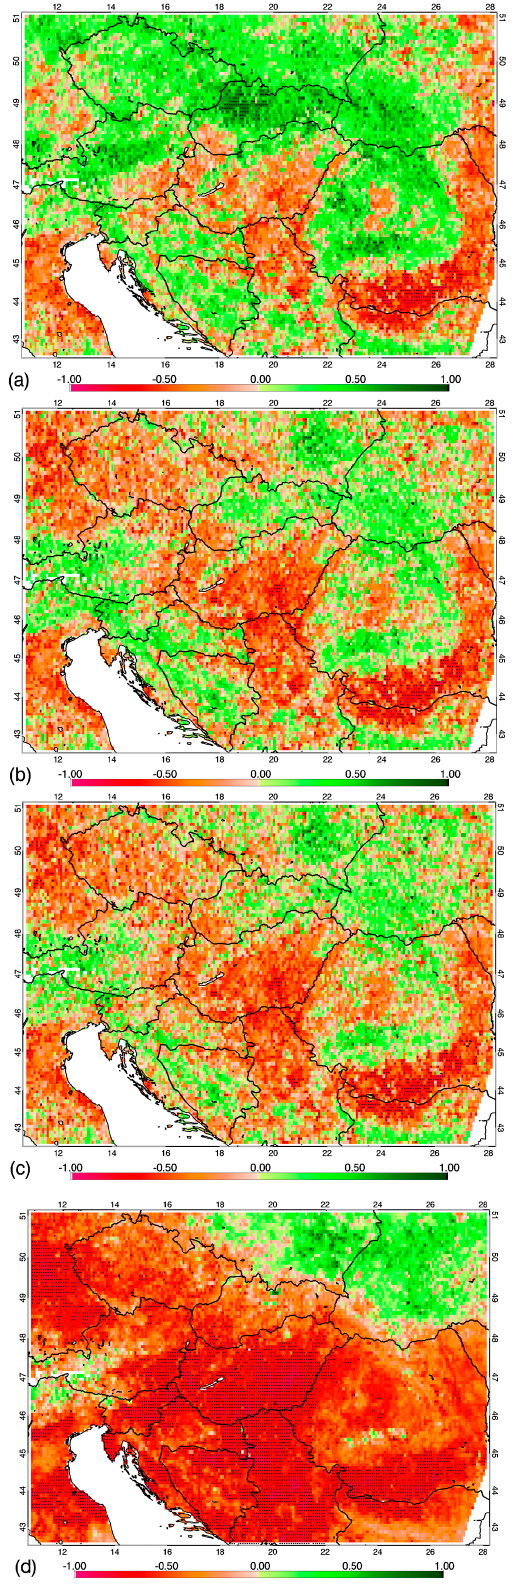
Figure 8. Map of R values between the temperature anomaly in August and the NDVI anomaly in August derived from ( a ) the NDVI3g O ; ( b ) NDVI3g F ; ( c ) NDVI3g H and ( d ) NDVI MODIS datasets. Pixels with dots inside indicate statistically significant R (p < 0.01).